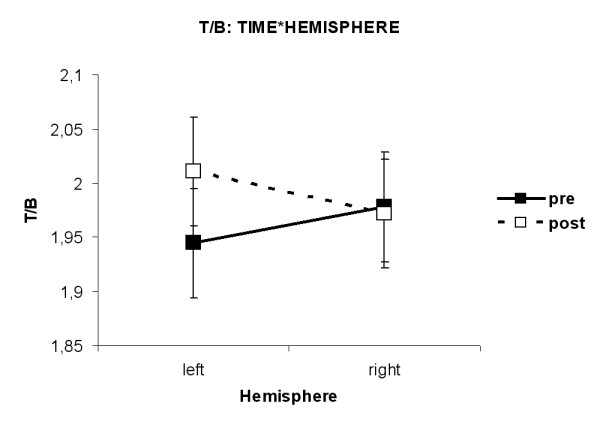
Interaction TIME*HEMISPHERE for T/B ratio. The Theta/Beta ratio was higher after administration of MPH than before MPH in the left hemisphere only (p = 0.02).